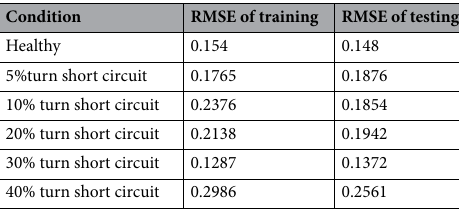
Table 8. ANFIS evaluation in different conditions.